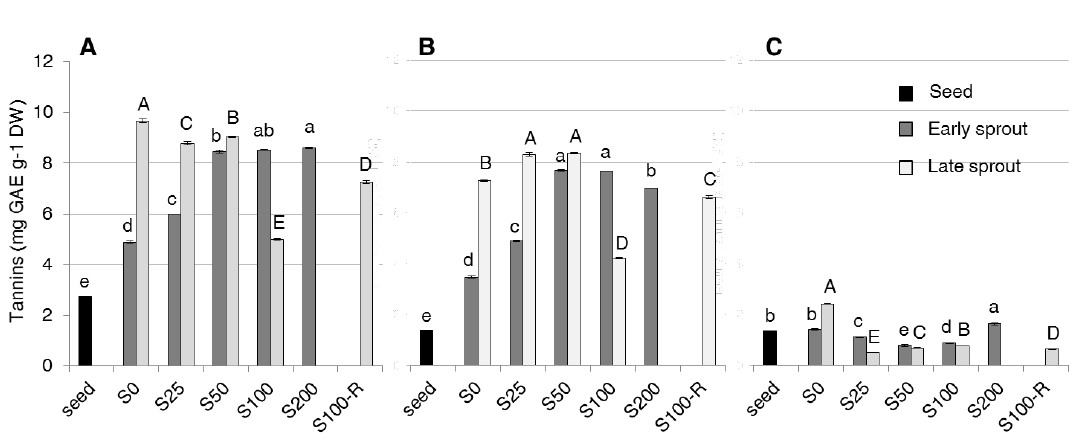
Figure 3. Total ( A ), free ( B ) and bound ( C ) tannin (TAN) content (mg GAE g − 1 DW) in seeds, early and late sprouts of rapeseed sprouted and grown with salt (NaCl) concentration 0, 25, 50, 100, 200 mM (S0, S25, S50, S100, S200, respectively) or sprouted with 100 mM and then grown with distilled water as recovery treatment (S100-R). Average values of duplicate determinations ± standard error are depicted. Different letters within each graph indicate statistically significant differences at p = 0.05 (Fisher’s LSD). Lower case letters are for comparison within early sprouts; upper case letters for comparison within late sprouts.